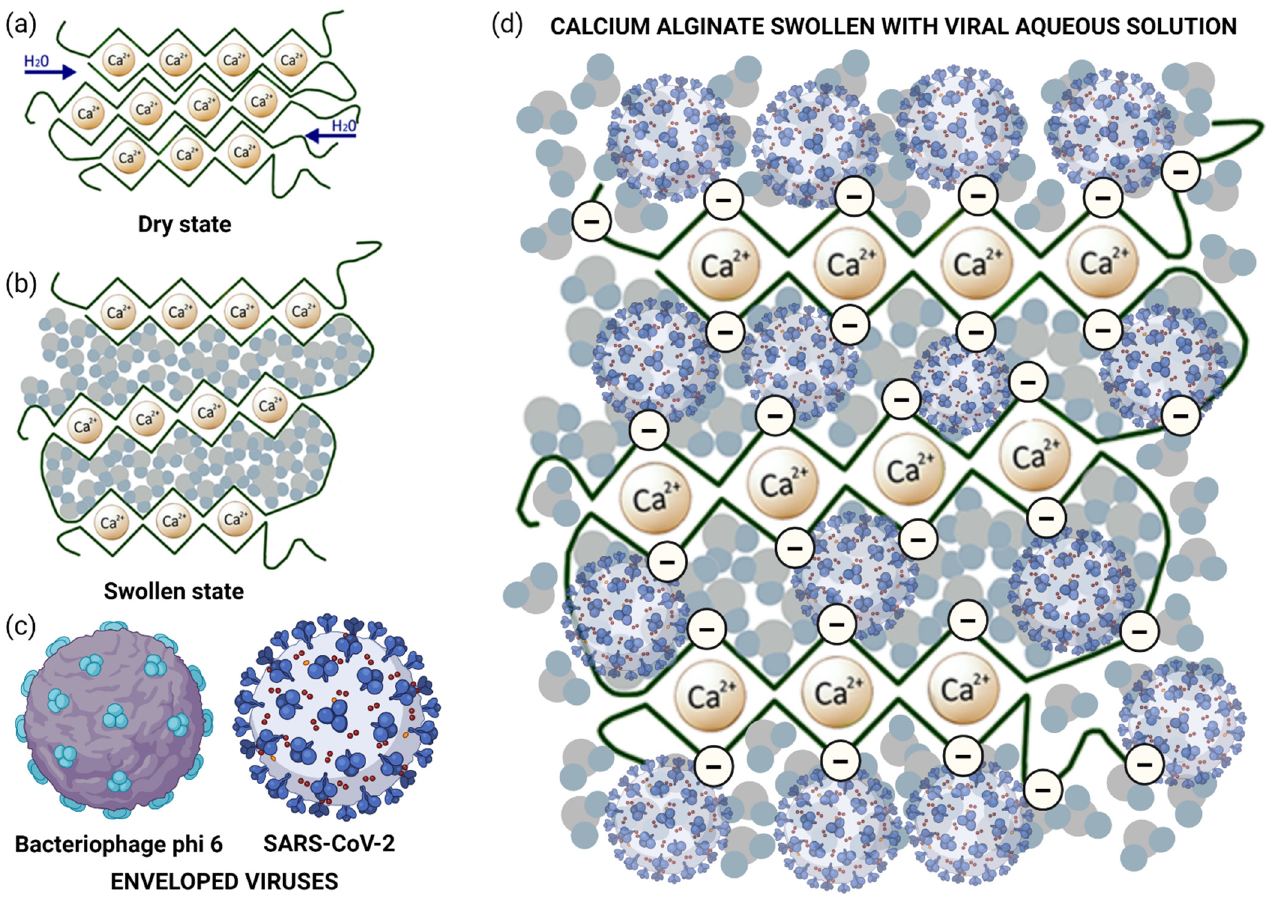
Figure 6. Inactivation mechanism of SARS-CoV-2 Delta variant and bacteriophage phi 6, in the synthesized negatively charged calcium alginate film: ( a ) calcium alginate structure in dry state according to the egg-box model Reprinted with permission under a Creative Commons CC BY License from ref. [21]. Copyright 2017 Spinger Nature; ( b ) calcium alginate in swollen state after being in contact with a viral aqueous solution Reprinted with permission under a Creative Commons CC BY License from ref. [21]. Copyright 2017 Spinger Nature; ( c ) enveloped RNA viruses: bacteriophage phi 6 and SARS-CoV-2 viral morphologies. Created by Á ngel Serrano-Aroca with Biorender.com; and ( d ) negatively-charged calcium alginate interfering with SARS-CoV-2 Delta variant in viral aqueous solution. Created by Á ngel Serrano-Aroca with